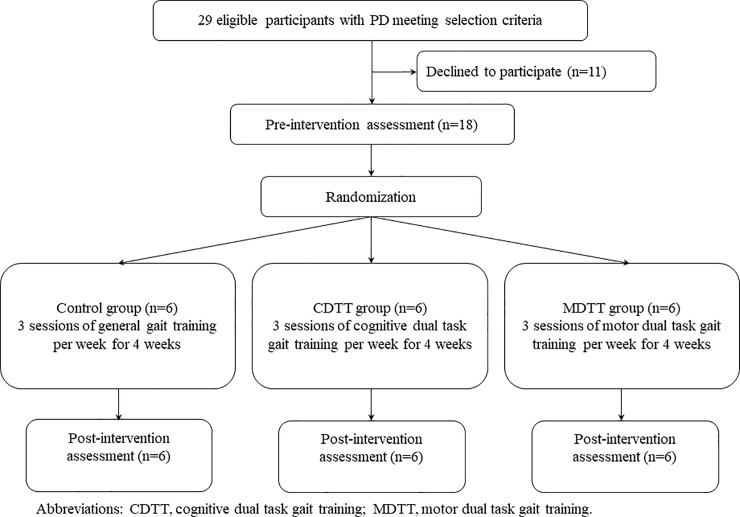
Study flowchart.